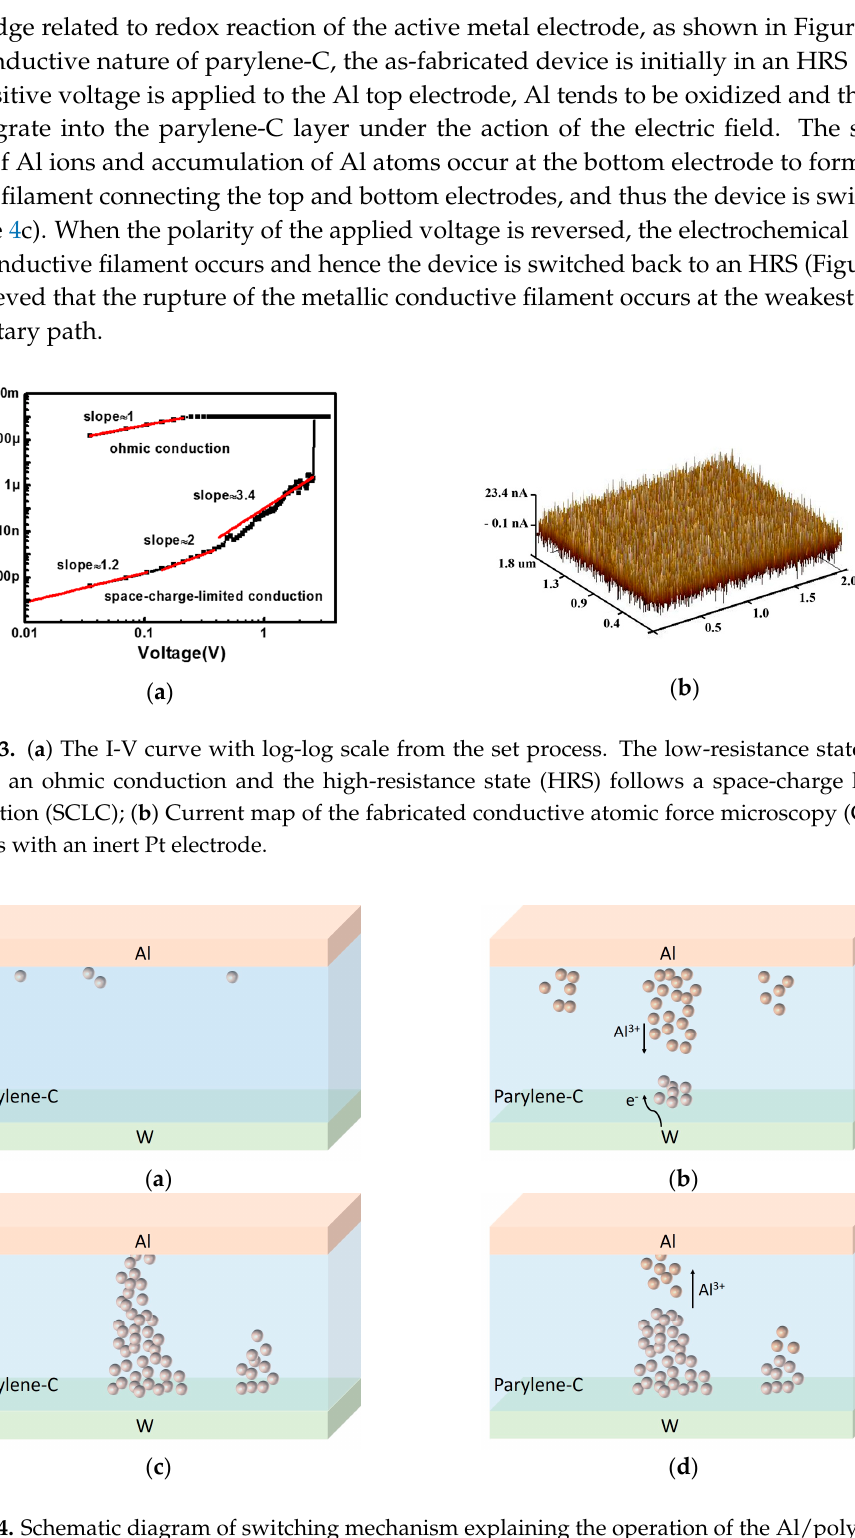
Figure 4. Schematic diagram of switching mechanism explaining the operation of the Al/polychloro- para-xylylene (parylene-C)/W device; ( a ) Initial low current state of the as-fabricated device; ( b ) Oxidation of Al at the top electrode, the migration of the Al ions into the parylene-C and the reduction of Al ions at the bottom electrode; ( c ) Formation of an Al conductive filament connecting the top and bottom electrodes; ( d ) Dissolution of the Al conductive filament at the weakest position of the filamentary path.